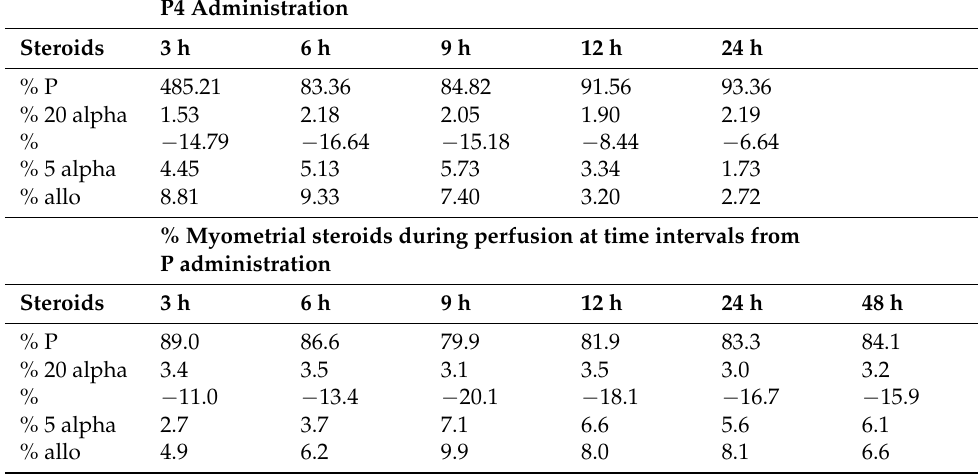
Table 1. Progesterone is metabolized in the human uterus into three primary metabolites, which may carry out all or part of progesterone effects on the myometrium. Adapted with permission from Ref. [112]. Copyright © 2001 American Society for Reproductive Medicine. Published by Elsevier Inc. All rights reserved.